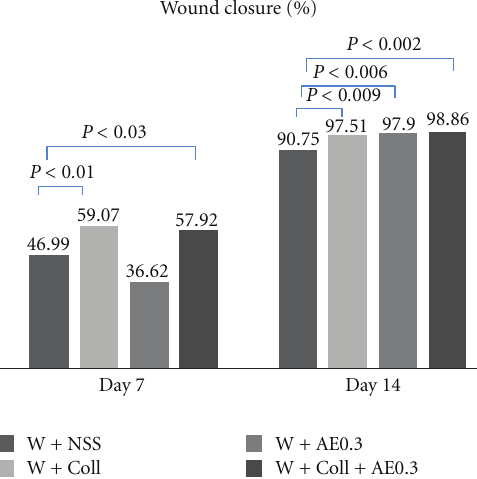
Figure 4: Percentages of wound closure in the W-NSS, W-AE, W- Coll, and W-Coll-AE groups were determined on days 7 and 14 after operation (mean ± SEM). ∗ P < 0 . 05 compared with control group. NS (nonsignificantly) compared with control.